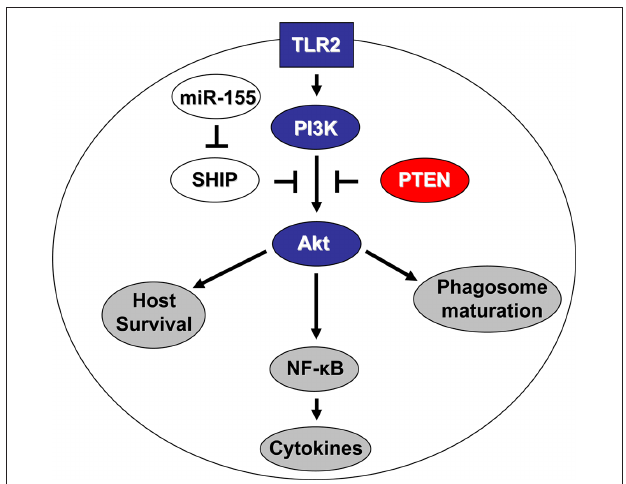
FIguRe 1 | Francisella tularensis tularensis targets the PI3K/Akt pathway at multiple levels. Blue represents downregulated genes, red upregulated, white unchanged, and gray the resulting cellular outcomes. TLR2 is required for full PI3K activation by Francisella , which in turn activates Akt. Active Akt promotes NF- κ B activation and cytokine production, as well as phagosome maturation and host cell survival. However, the phosphatases SHIP and PTEN antagonize this Akt activation. SHIP expression is inhibited by miR-155, which is induced by the low-virulence but not high-virulence subspecies of Francisella . This lack of miR-155 induction by the high-virulence subspecies leads to maintenance of SHIP levels. The other phosphatase PTEN is upregulated and maintained in a highly active state upon infection with high-virulence Francisella